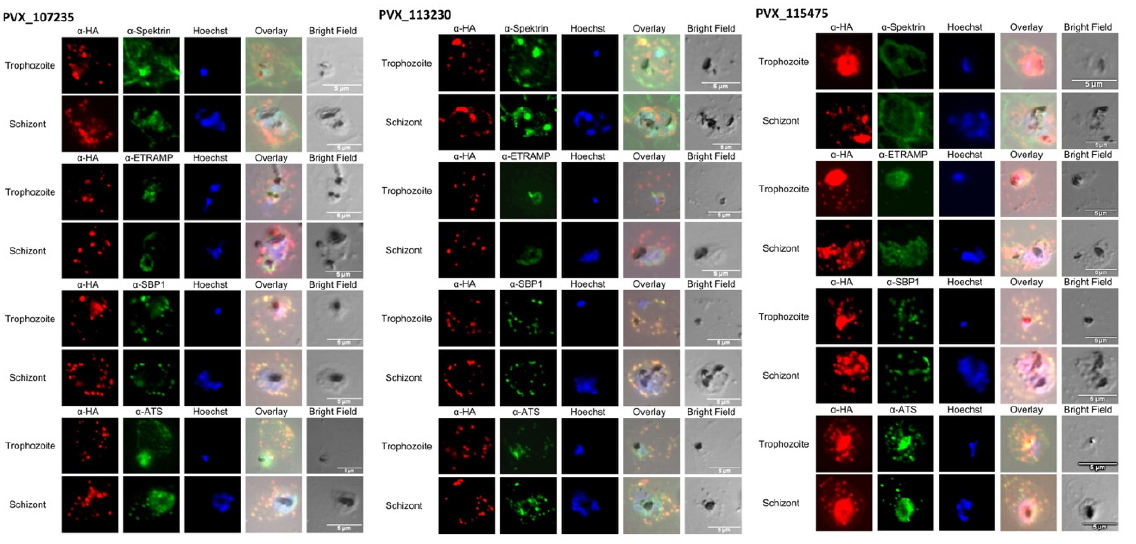
Figure 2. Localization of VIR proteins (PVX_050690, PVX_060690, PVX_068690, PVX_093715, PVX_096925, PVX_077695, PVX_081850, PVX_097525, PVX_101560, PVX_107235, PVX_113230, and PVX_115475) in erythrocytes infected with P. falciparum 3D7 transfectants expressing the corresponding vir genes. Pf IEs were fixed with acetone, and VIR proteins were localized with α -HA (red) in the trophozoite stage and schizont stage Pf IEs. Colocalization was performed with α -Spectrin, α -ETRAMP, α -SBP-1, and α -ATS (green). The cell nuclei were stained with Hoechst-33342 (blue). See also Figure S3.